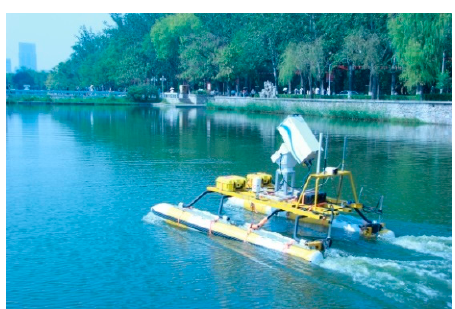
Figure 4. Turning test of Dolphin-I . Table 1. Unmanned surface vehicle (USV) parameters and turning test data.